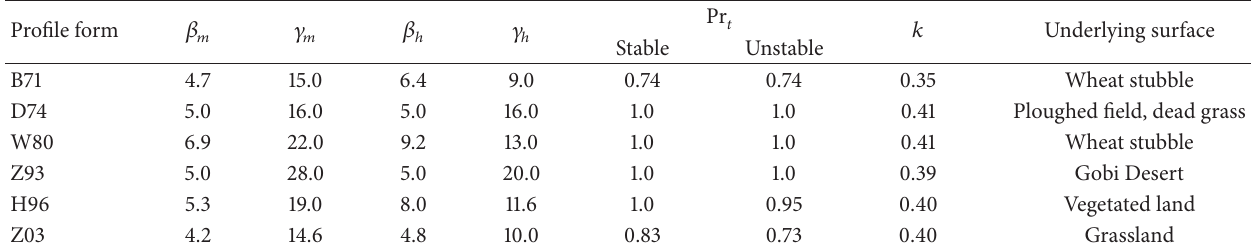
Table 1: Coefficients in six typical forms of nondimensional profile functions a . Profile